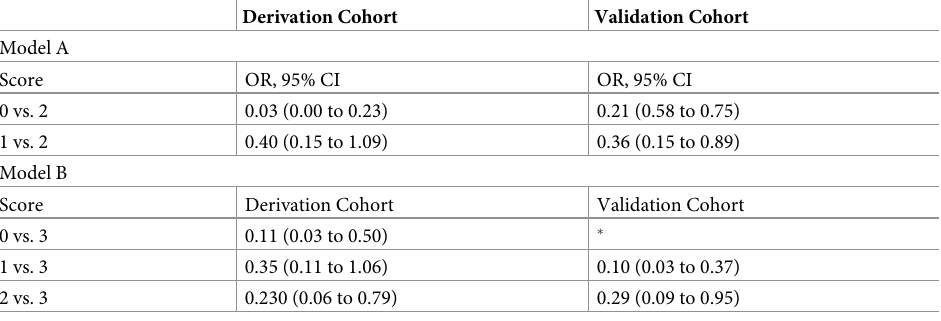
Table 3. Mortality risk by